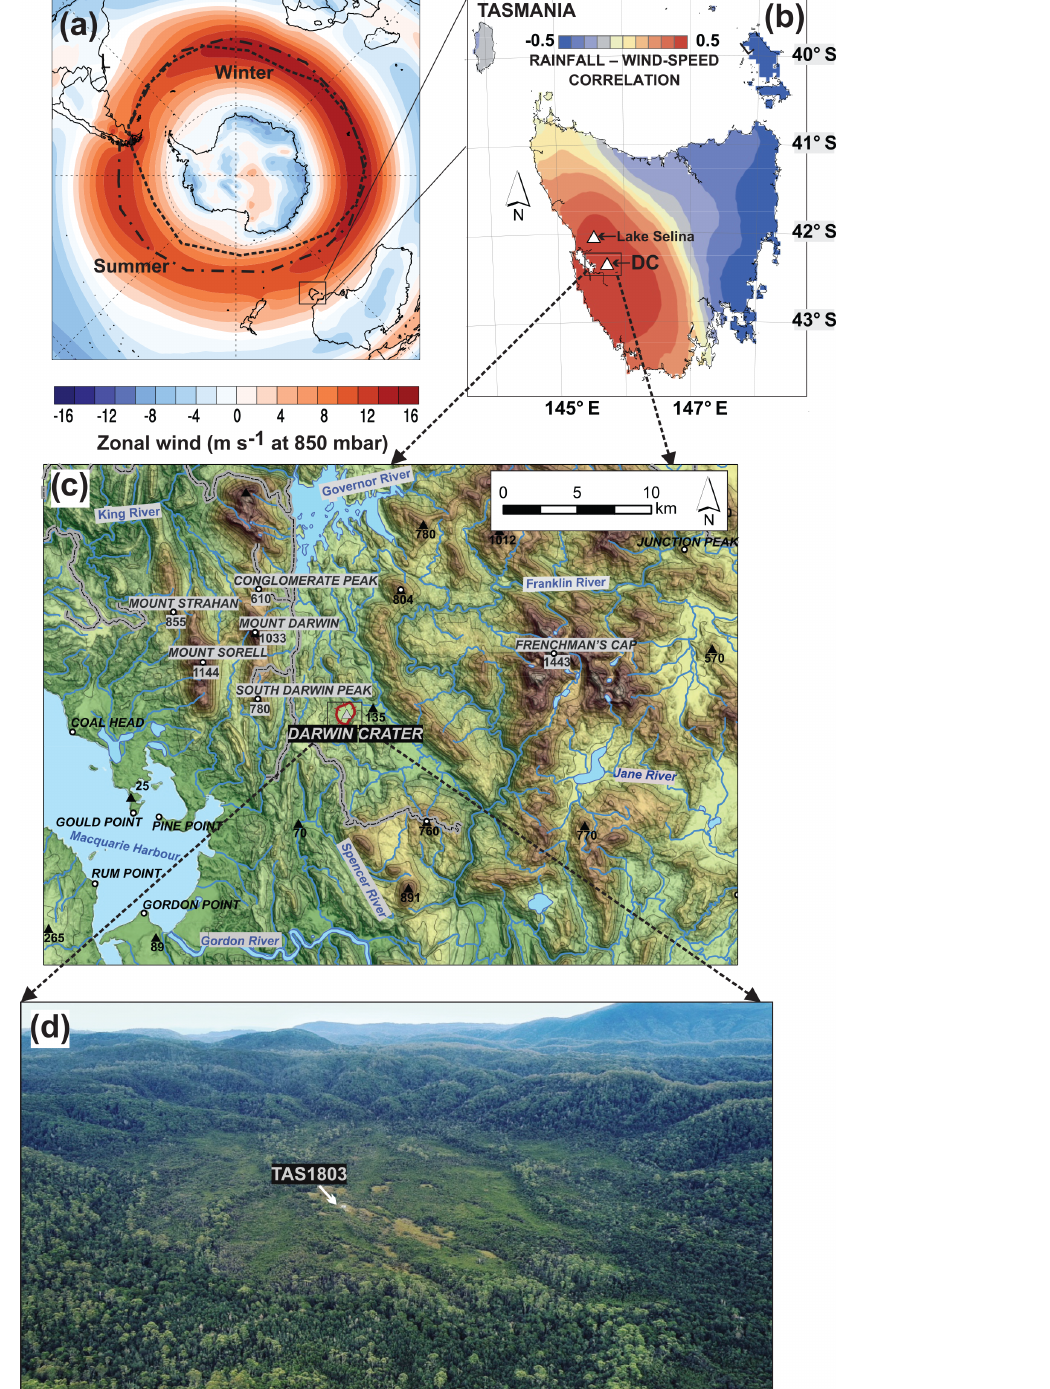
Figure 1. (a) Zonal wind speed at 850mbar in the mid-latitude of the Southern Hemisphere, and average winter and summer core position of the Southern Hemisphere westerly winds (SWWs). (b) The SWWs are a dominant climate control in western Tasmania, where rainfall is strongly correlated to wind intensity and orography. (c) Regional topographic map showing the location of Darwin Crater, and (d) aerial oblique drone image of Darwin Crater during the scientific drilling operations in April 2018. The drill and camp site are visible in white. Wind data from the NCEP and NCAR Reanalysis V1 (Kalnay et al.,